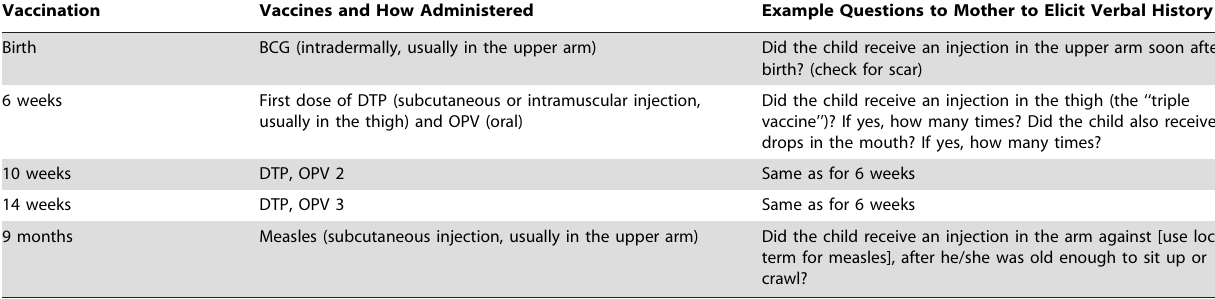
Recommended Age for